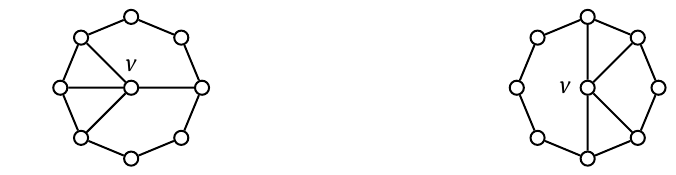
Figure 1: Two graphs that are cospectral for the adjacency matrix by Godsil-McKay switching about S = { v } .